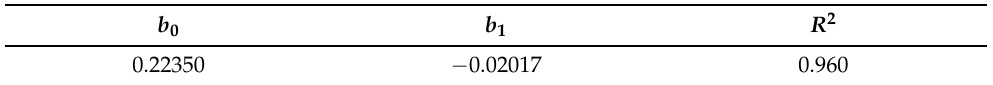
Table 2. Fit parameters for the E b / ( Mc 2 ) – Λ linear relation of Equation (32). The R 2 index is also included for completeness.